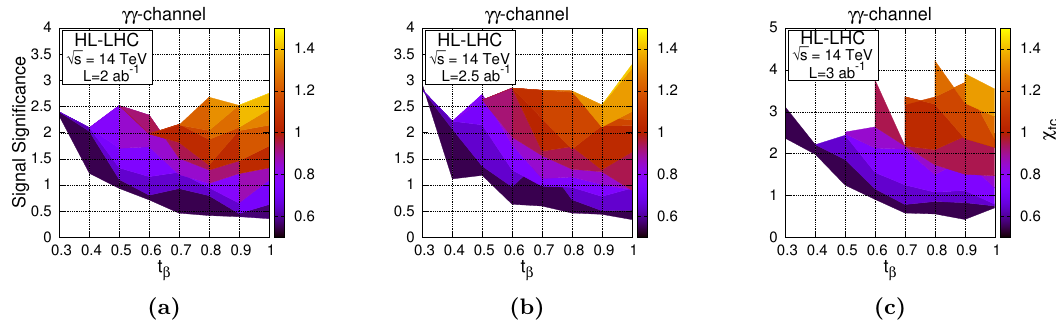
Figure 7. Density plots for the signal signi(cid:12)cance as a function of the t (cid:12) and (cid:31) tc for three illustrative integrated luminosities: (a) L =2 ab (cid:0) 1 , (b) L =2.5 ab (cid:0) 1 , (c) L =3 ab (cid:0) 1 . The case (c) represents the (cid:12)nal integrated luminosity reached by the